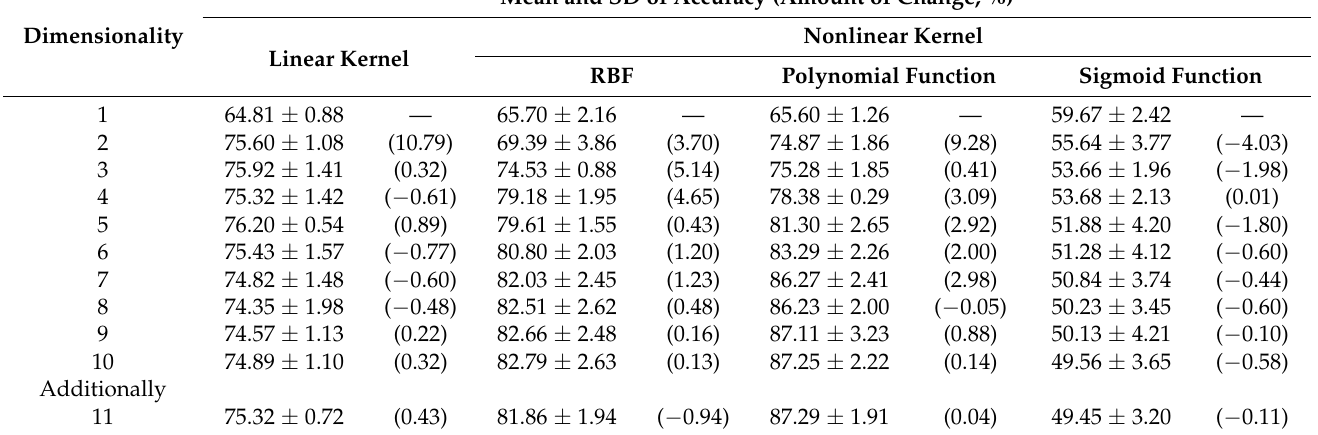
Table 3. Comparison of dimensionality (mean and SD) of classification accuracy in one linear kernel and three nonlinear kernels a